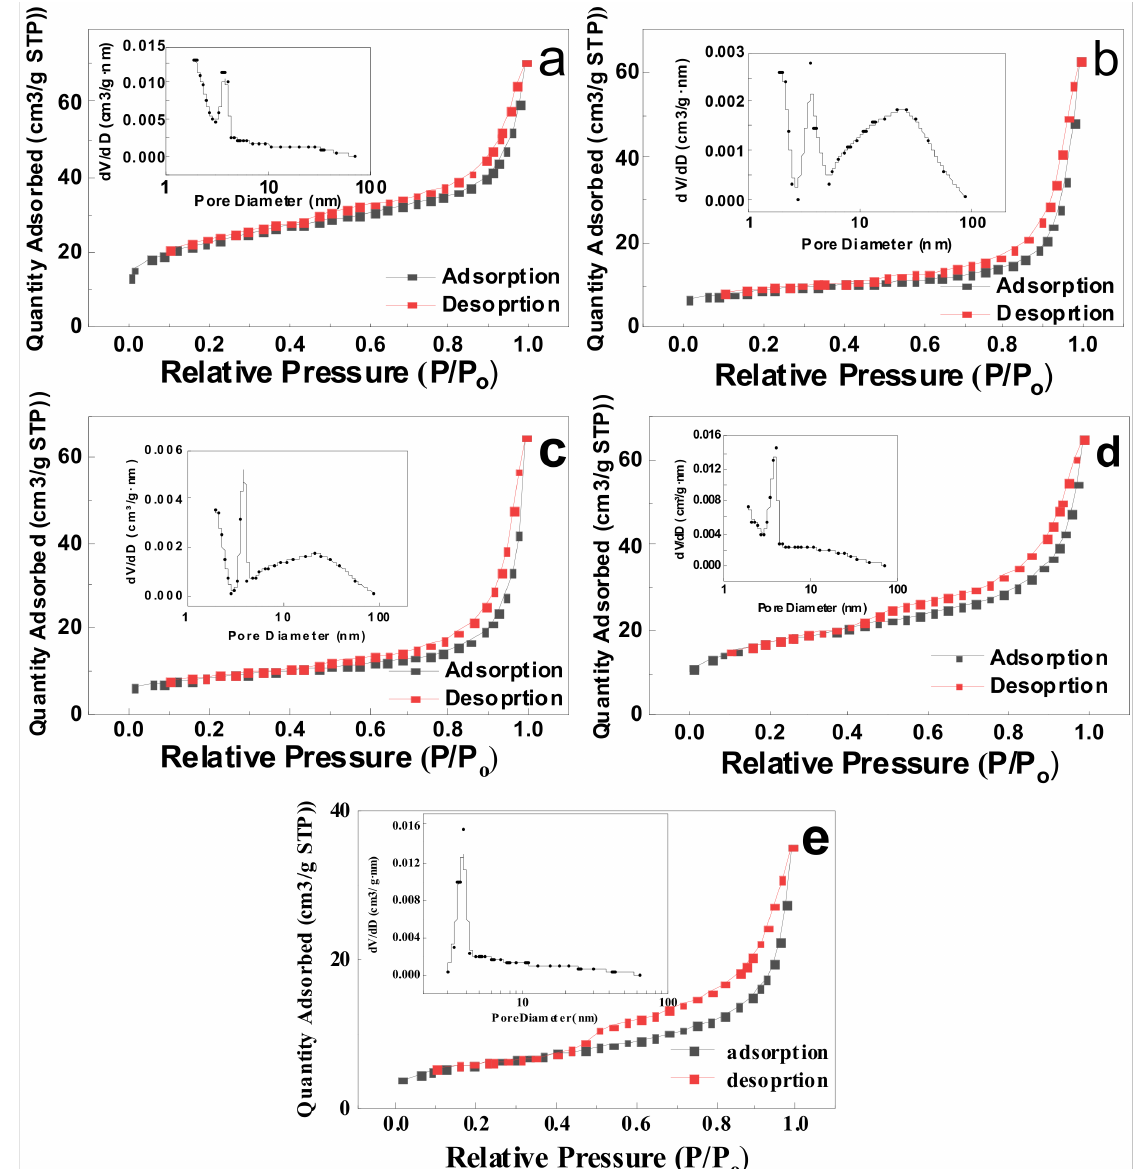
Figure 6. Nitrogen adsorption and desorption curves and pore size distribution of the five catalysts: